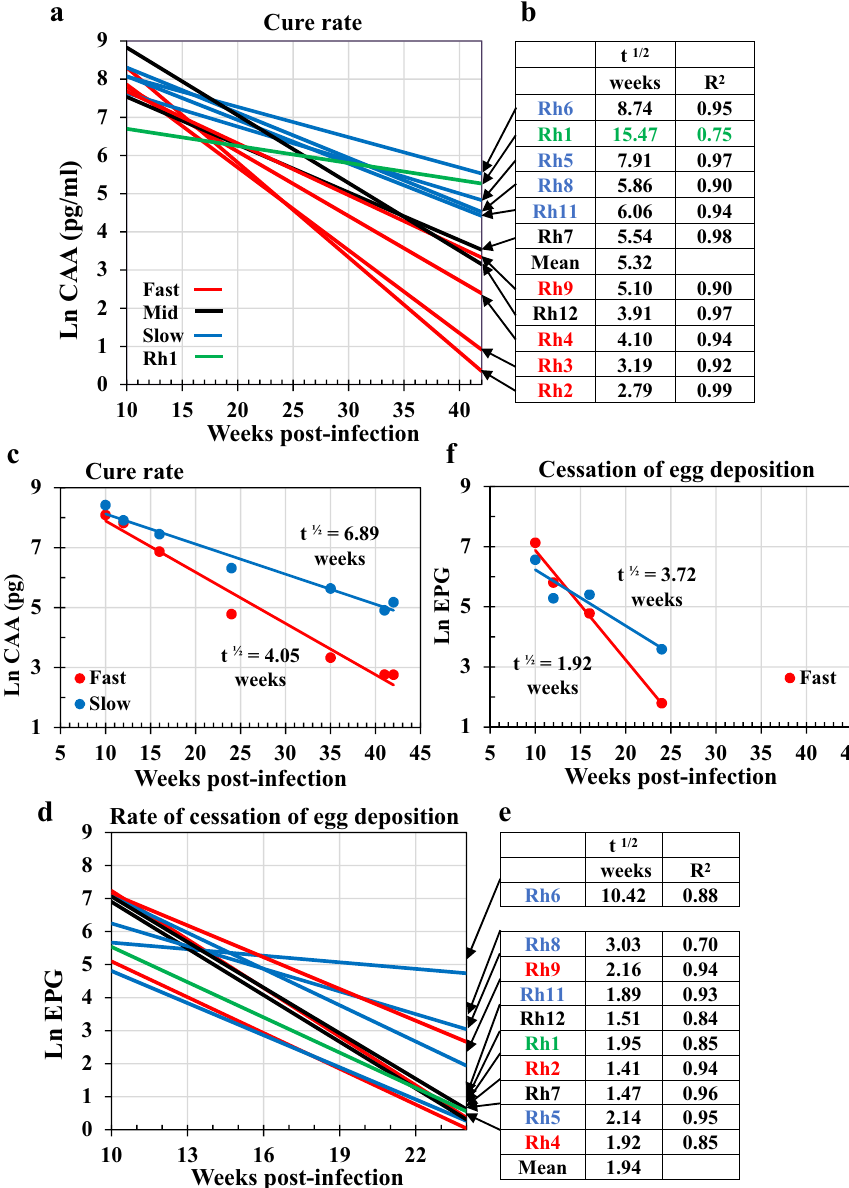
Fig. 3 Analysis of the self-cure phase between Weeks 10 and 42 post-infection. a Cure-rate for each animal, determined by fi tting a linear regression to an Ln-transform of the negative exponential circulating anodic antigen (CAA) dataset, where t½ = ln2/ λ = 0.693/regression slope. The colours of plot lines denote strati fi cation into Fast (red), intermediate (black), and Slow (blue) responder groups, plus Rh1 (green). b The t½ cure-rates tabulated by value to illustrate the basis for strati fi cation. The R 2 values in column three indicate the goodness of fi t of each regression equation to the raw data. c The mean cure rate of Fast and Slow groups based on Ln CAA values. The slopes were tested for difference from each other using the Student ’ s t- test, giving a t -value of 4.832 with 10 df and P = 0.00069; n = 4 macaques from the Slow and 4 from the Fast groups. d The rate of cessation of egg deposition fi tted to the Ln- transform of the negative exponential eggs per gram (EPG) dataset. The plot lines are not in the same order as in the CAA strati fi cation in a . e The t½ for the rate of cessation of egg deposition approximately ordered by value. The R 2 values in column three indicate the goodness of fi t to each regression equation. In almost all instances the values are lower than for CAA. f Mean rate for cessation of egg deposition of Fast and Slow groups, based on Ln EPG values. For the cessation of egg deposition, the signi fi cance of the difference between the linear regression slopes was determined using an F -test that gave a t -value of 3.192, with 4 df and P = 0.0331; n = 4 macaques from the Slow and 4 from the Fast groups. Source data are provided as a Source Data fi